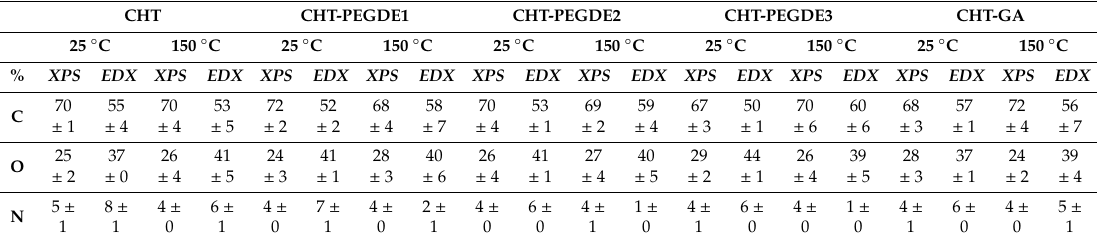
Table 4. XPS and EDX atomic percentage of C, O, N of chitosan films crosslinked with GA and PEGDE dried at 25 ◦ C and 150 ◦ C.